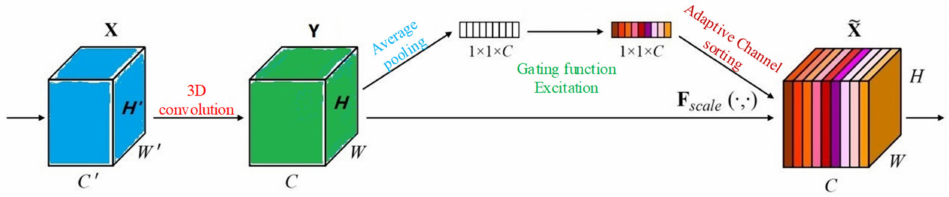
Figure 3. The squeeze-and-excitation block schematic